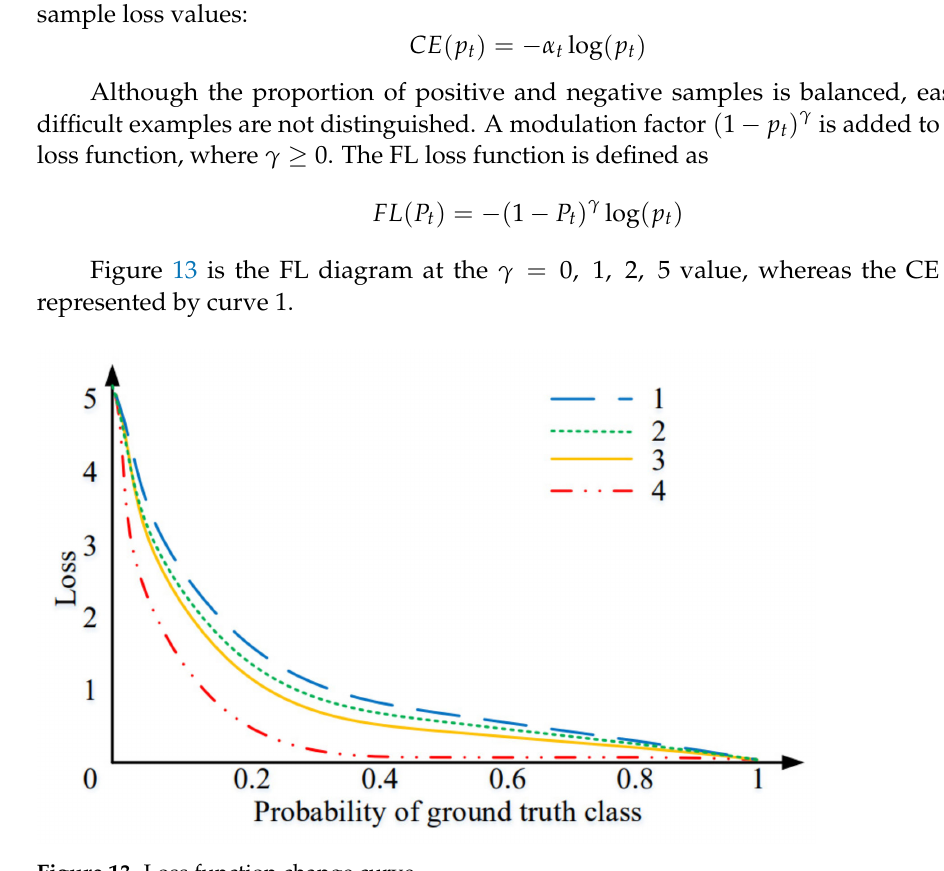
Figure 13. Loss function change